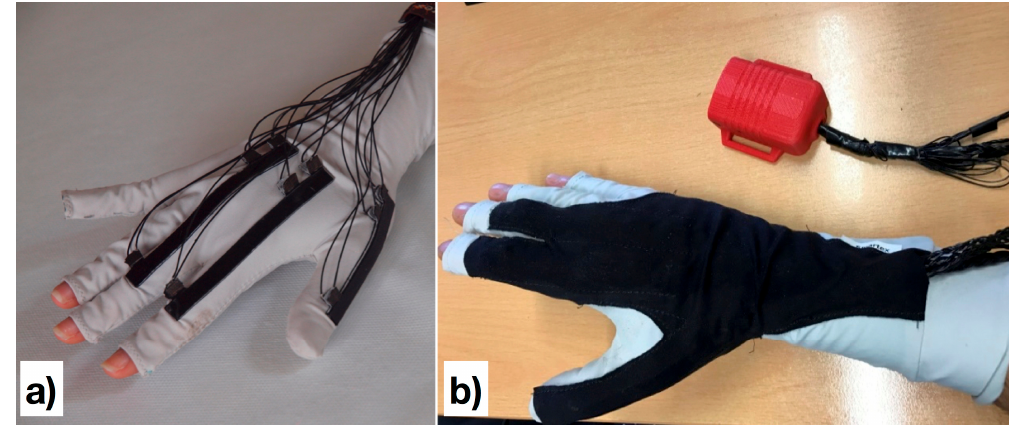
Figure 2. ( a ) The goniometers attached to the glove fabric, ( b ) the sensing glove prototype and the wireless acquisition unit.